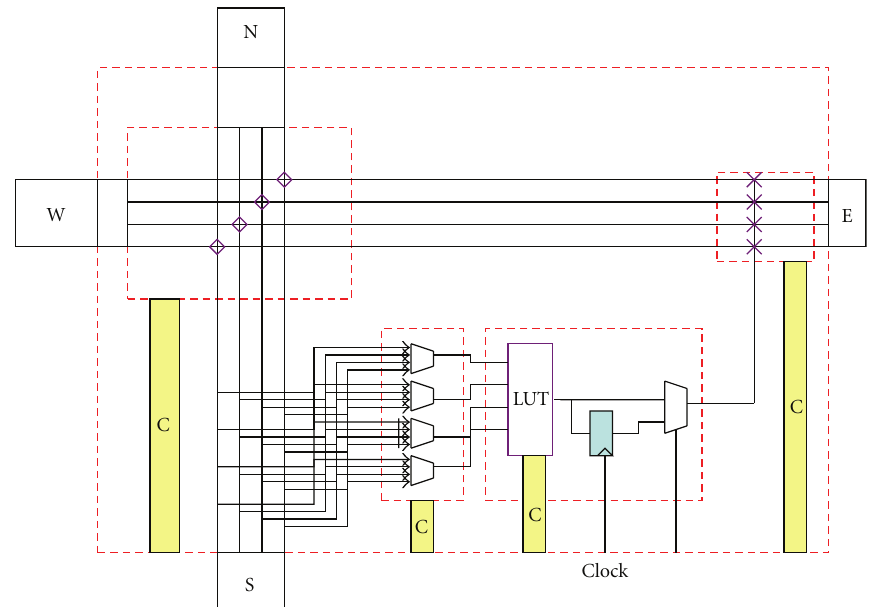
Figure 4: Structure of a basic cell (middle cell) within the RFU matrix.